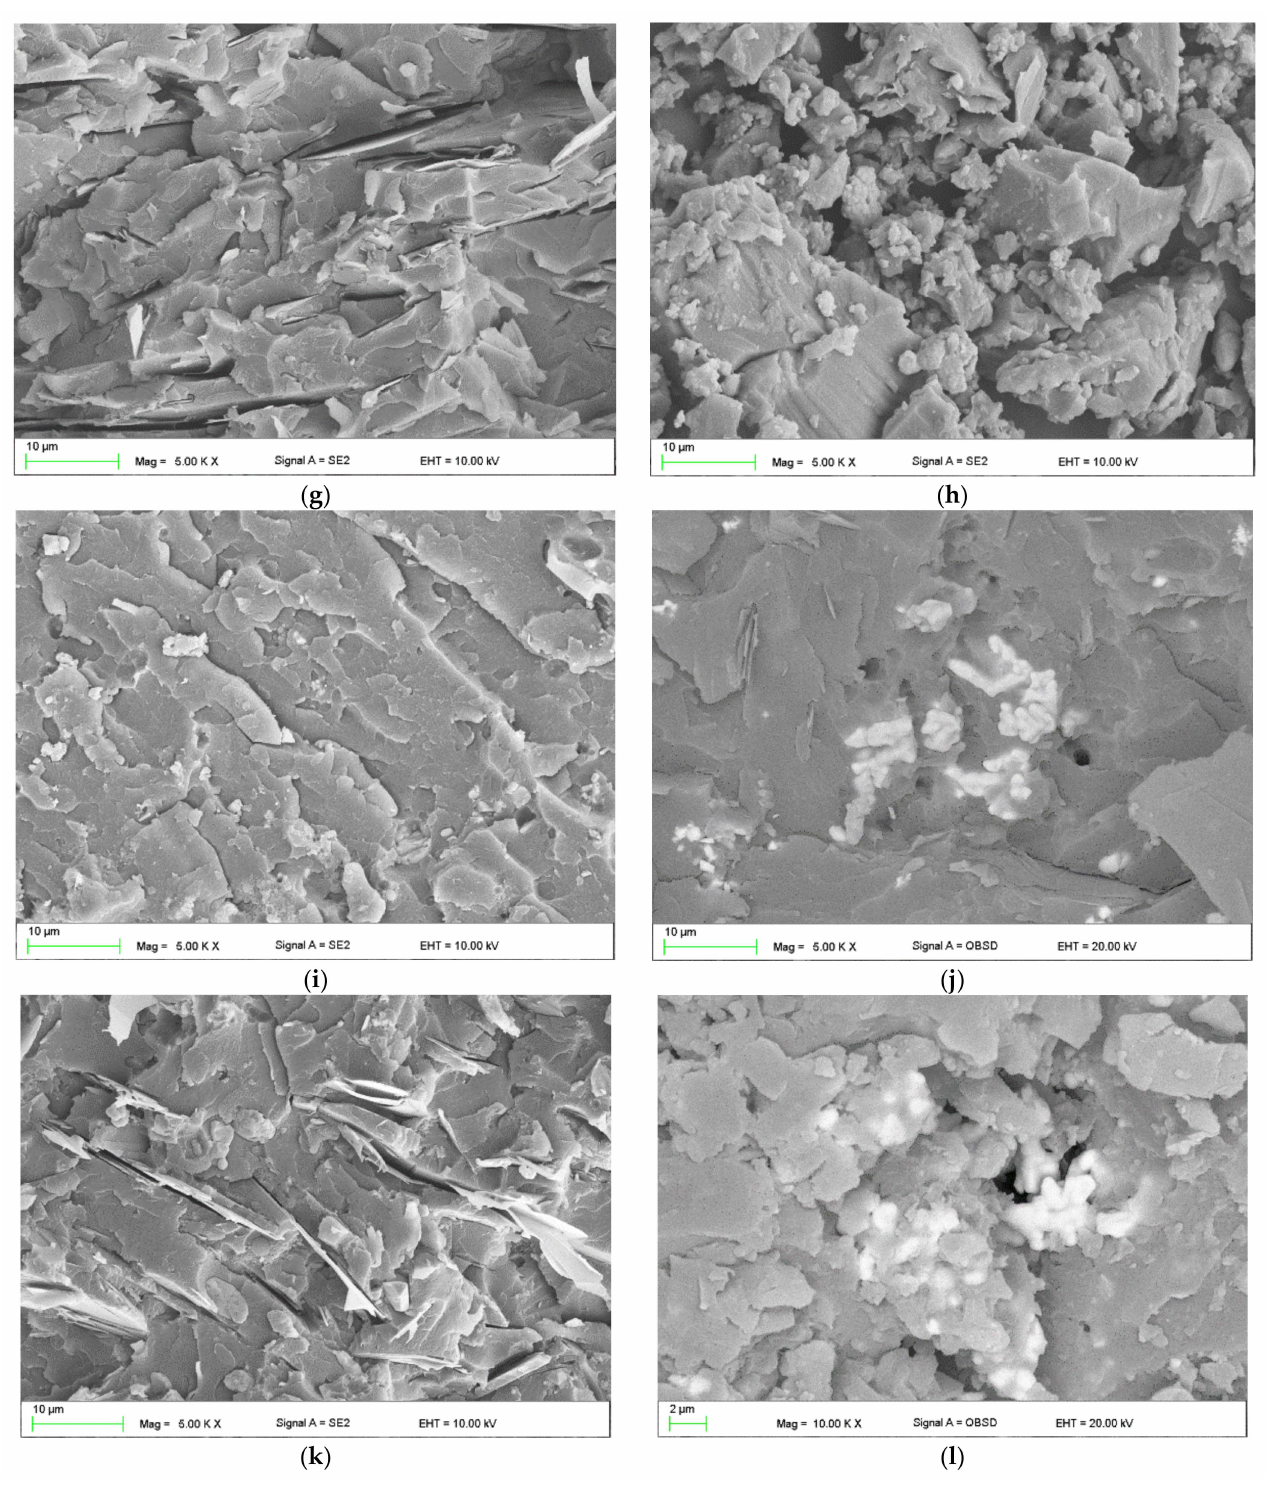
Figure 6. SEM images of tested materials: ( a ) E0, ( b ) E1, ( c ) E2, ( d ) E3, ( e ) W0, ( f ) W1, ( g ) -W2, ( h ) W2, ( i ) P0, ( j ) P1, ( k ) P2, ( l )